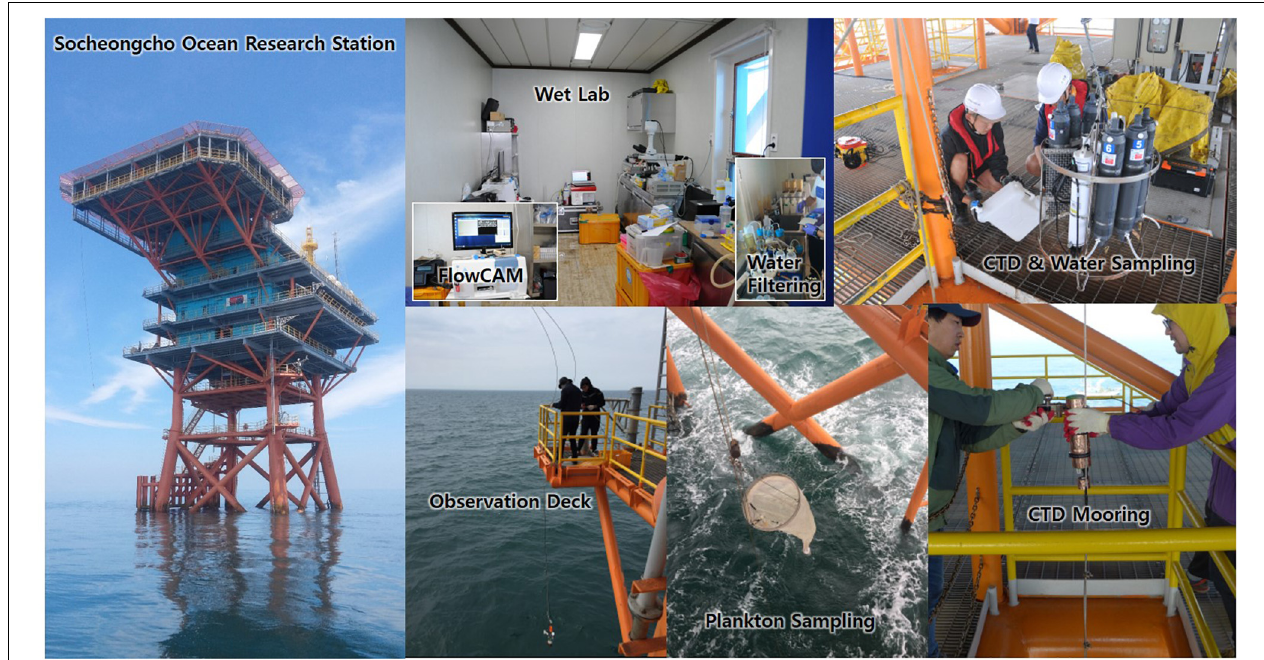
FIGURE 2 | An overview of the S-ORS: Research facilities and